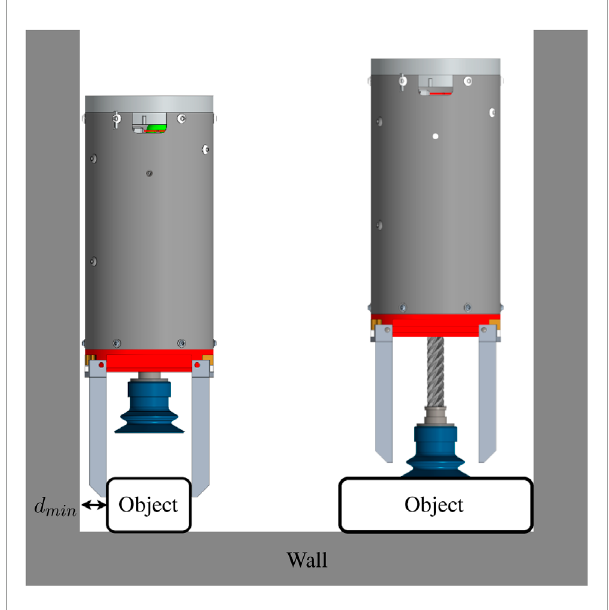
FIGURE 11 Grasping objects in bin or box with objects close to walls.